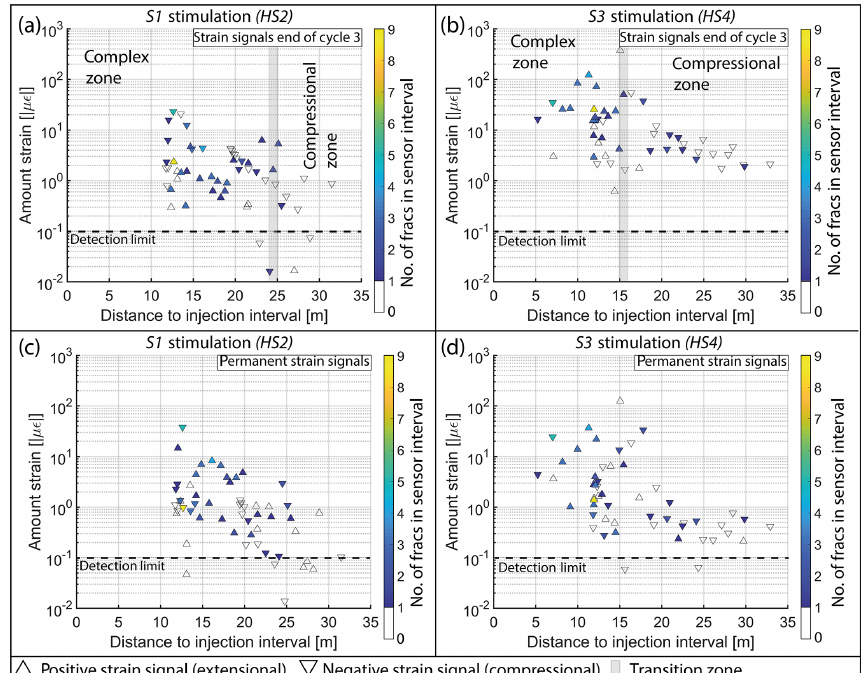
Figure 10. Strain signals with respect to distance to the injection point for HS2 and HS4. Generally, the strain perturbations prevailing at the end of the injection phase of cycle 3 were compressive beyond a certain distance, which varied between experiments. This distance is denoted by the vertical grey line in (a) and (b) and separates the compressional zone from the so-called “complex zone” wherein a mix of extensile and compressive strains is observed. The color code of the triangle indicates the number of fractures located within the FBG sensor